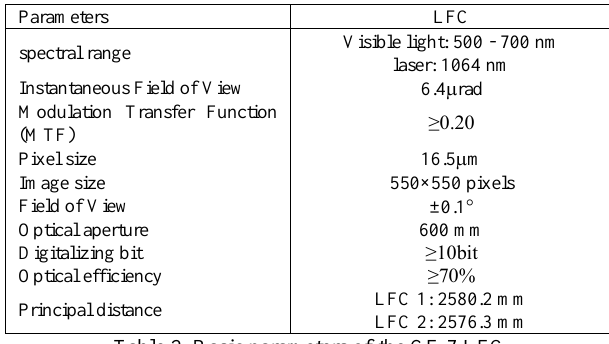
Table 2. Basic parameters of the GF-7 LFC 3. SPACEBORNE LASER ALTIMETER